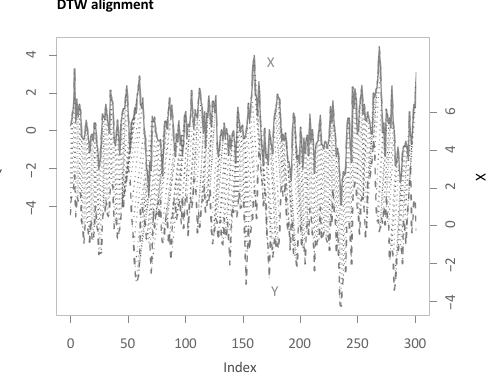
Figure 5. Alignment of the realizations of the two time series X and Y (see Equation (7)) through the first main